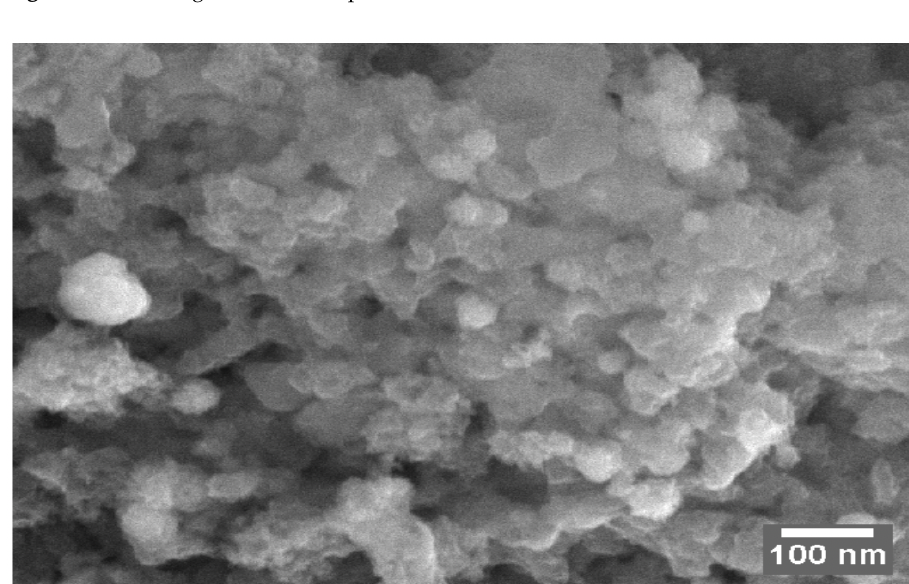
Figure 4. SEM image of TiO 2 nanoparticles.